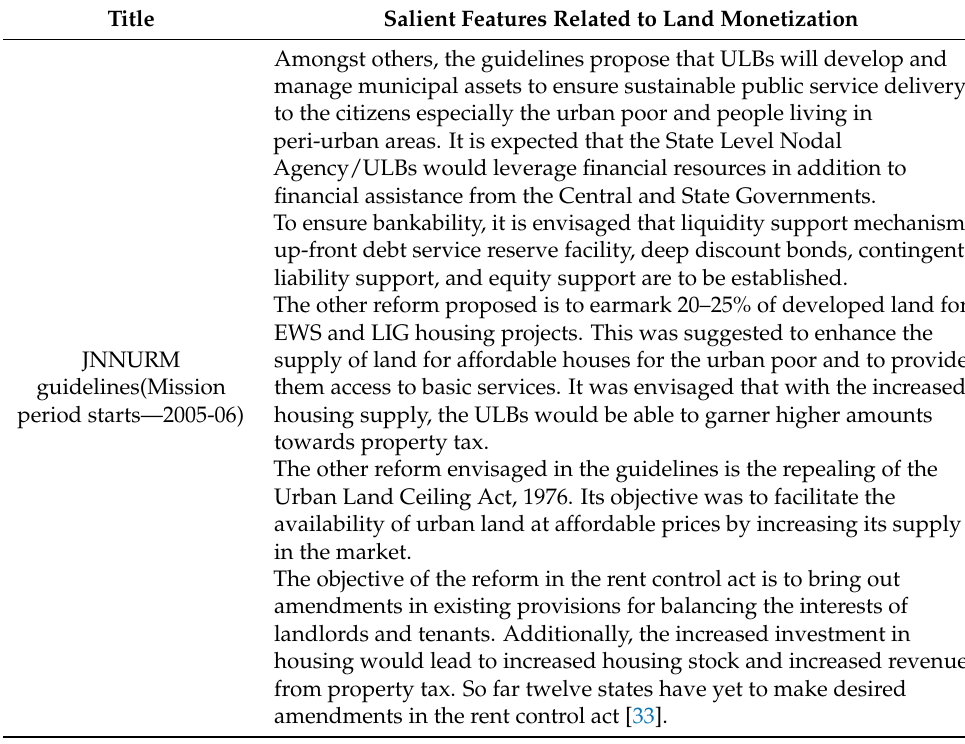
Table 3. Legislations/policies with land monetization